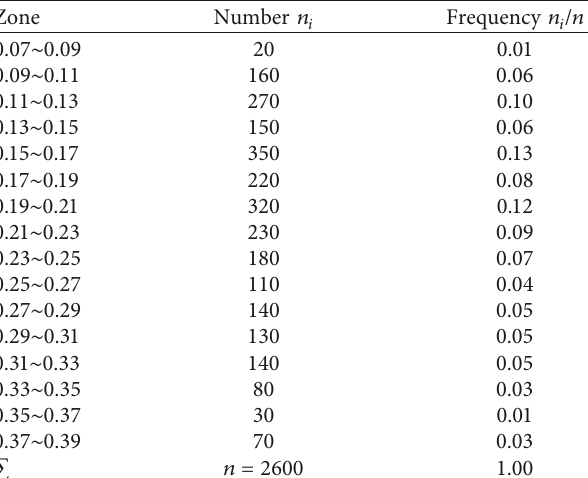
Table 3: The frequency of swaying load peak